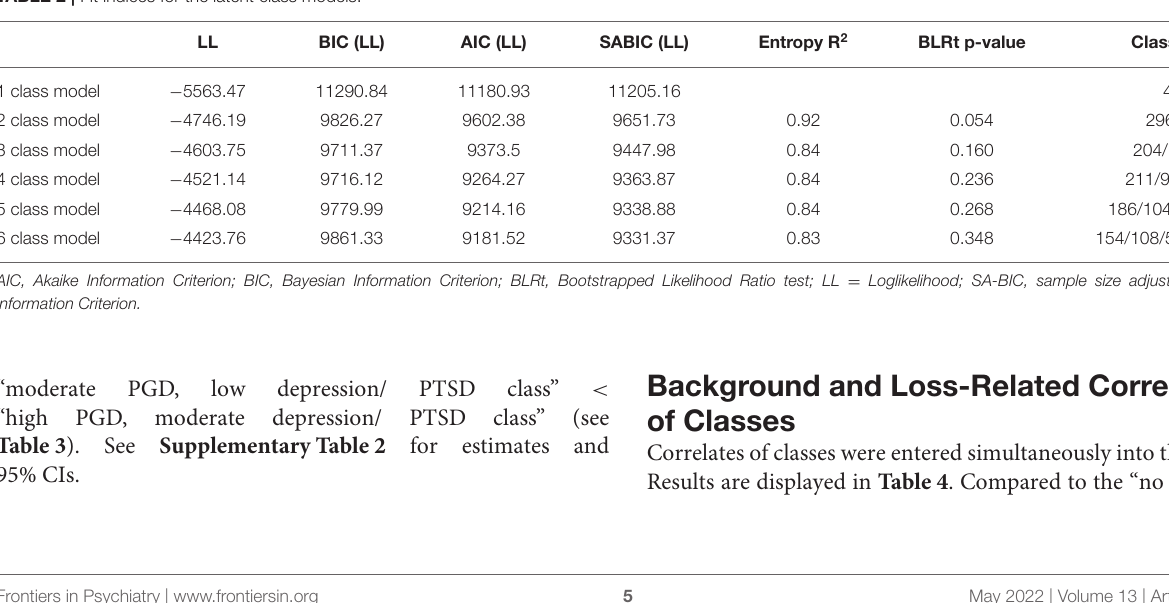
TABLE 2 | Fit indices for the latent class models.